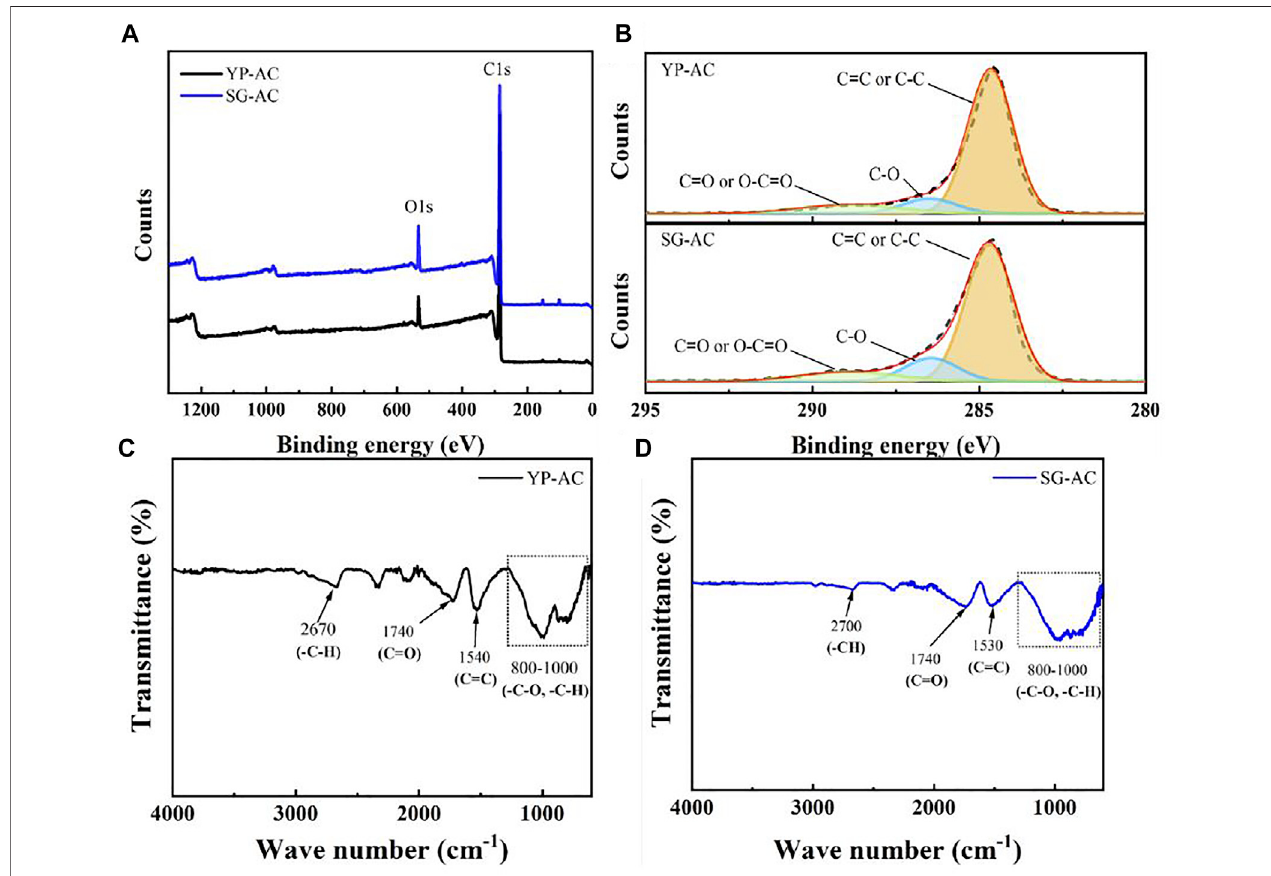
FIGURE 6| (A) Survey-scan XPS spectra ofYP-ACand SF-AC samples, (B) C 1speak ofYP-ACand SG-AC samples. FTIR spectra ofactivated carbons (C) YP- AC and (D) SG-AC.